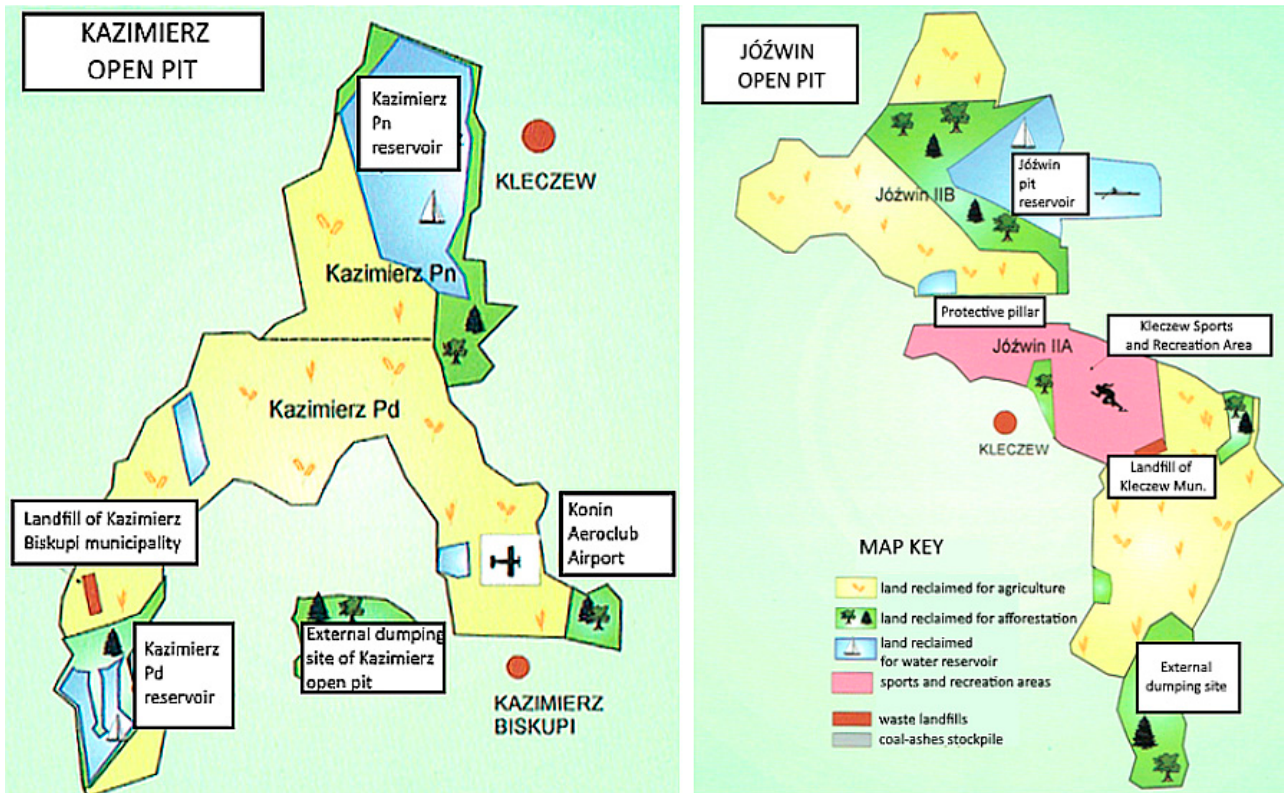
Figure 14. Post-mining land uses after the reclamation of “Kazimierz” ( left ) and “Jó ź win” ( right ) open pits [17].